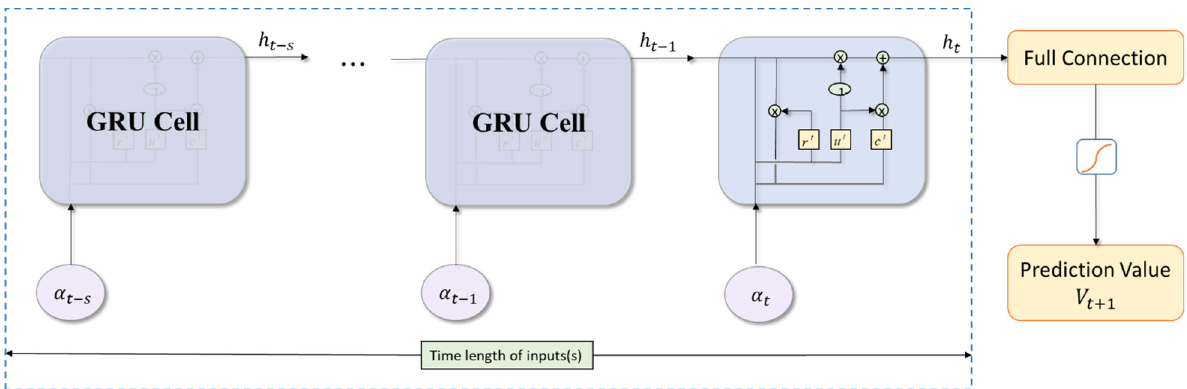
Figure 7. Gated recurrent unit (GRU) structure.